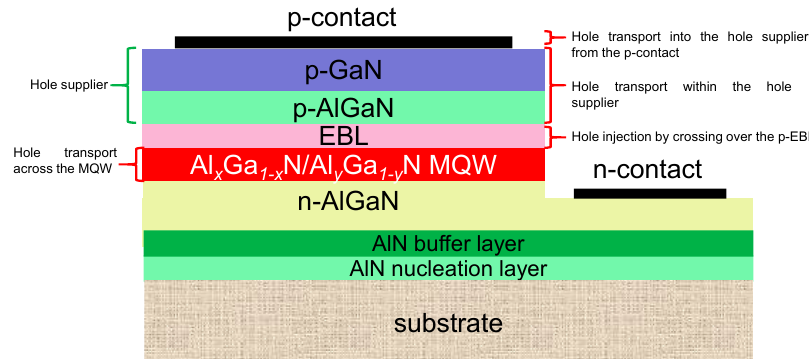
Figure 1. Schematic device architecture for a typical AlGaN based DUV LED and the four key factors that co-decide the hole injection efficiency. The hole supplier contains the p-AlGaN layer and the p-GaN layer.